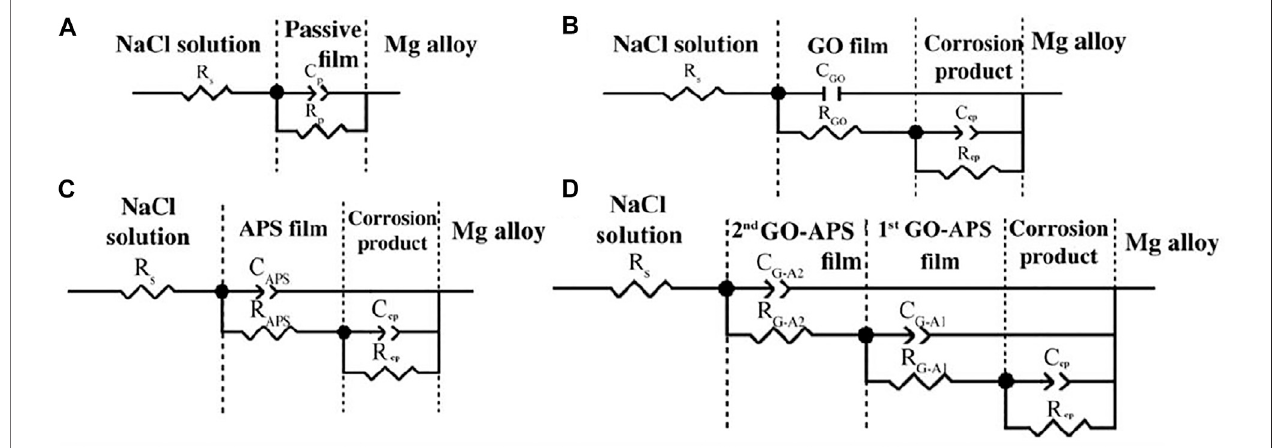
FIGURE 9 | Equivalent circuits of EIS results: (A) bare Mg alloy; (B) GO fi lm – coated Mg alloy; (C) APS fi lm – coated Mg alloy; (D) GO-APS fi lm – coated Mg alloy.